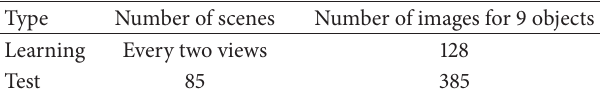
Table 1: Data statistics for learning and test.